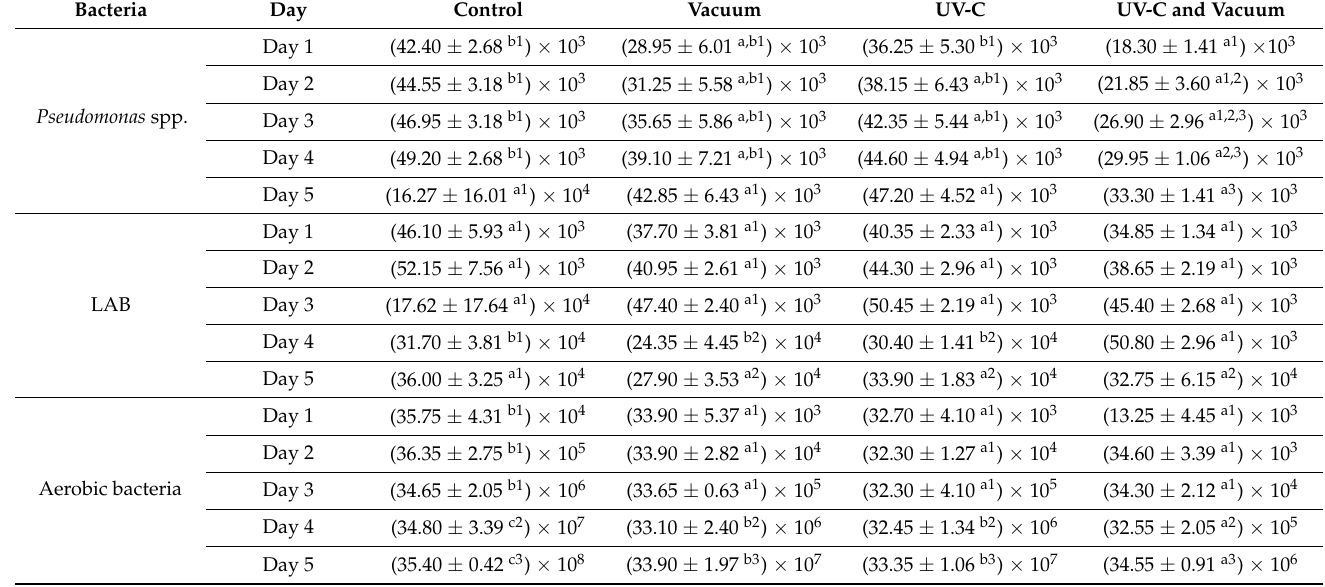
Table 1. The results of the one-way ANOVA analysis and Tukey HSD results of the mean microbial counts (CFU/g) of the beef